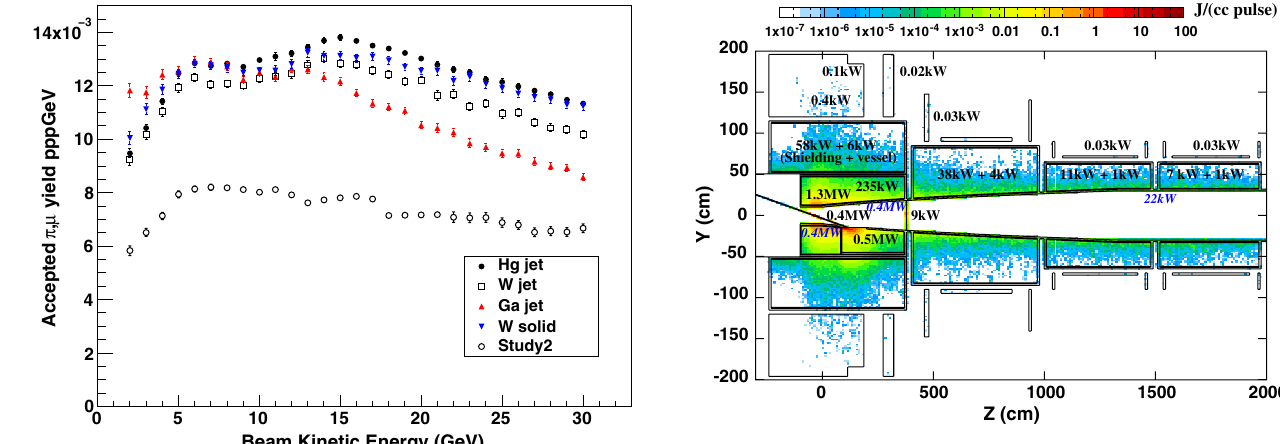
FIG. 6. The charged-averaged accepted pion and muon yield per proton per GeV for various targets in the new increased shielding geometry. Also shown are the equivalent yields for the mercury jet target in the Study 2 geometry.